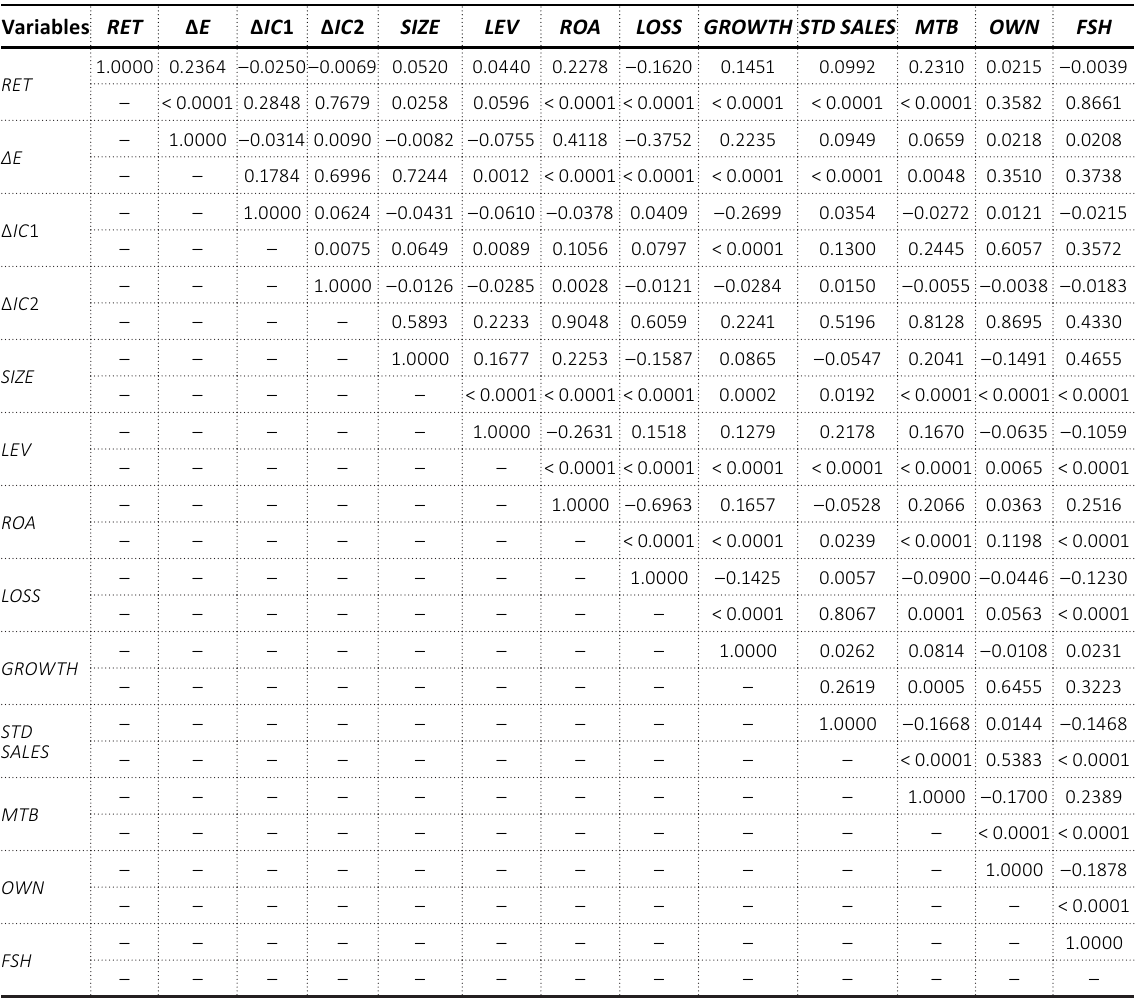
Table 3. Correlations of variables Variables